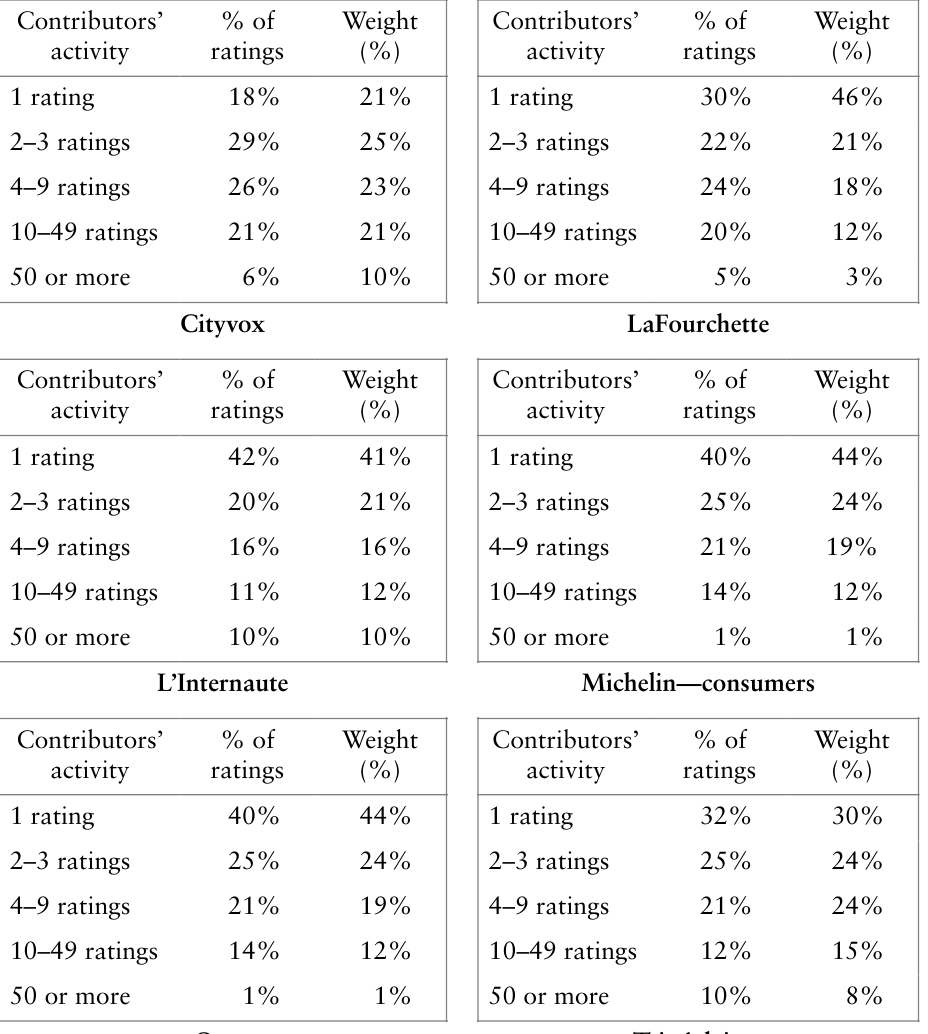
Table 9. Contributors’ weight in restaurant evaluation regarding their activity.